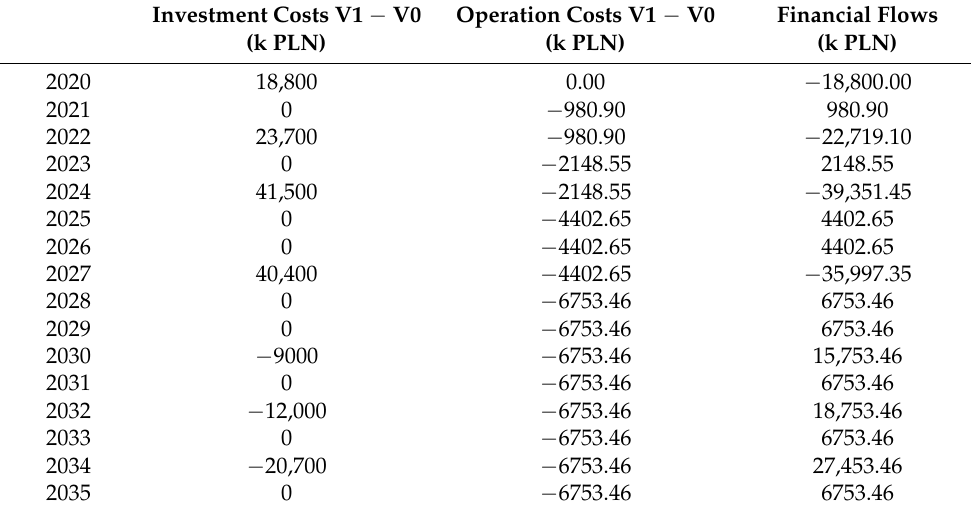
Table 5. Annual financial flows for the years